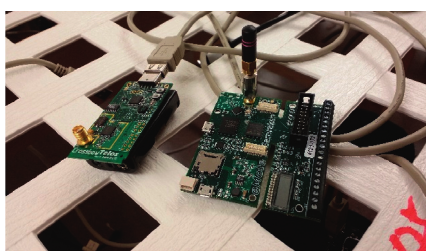
Figure 3: Node hardware of TinyOS and